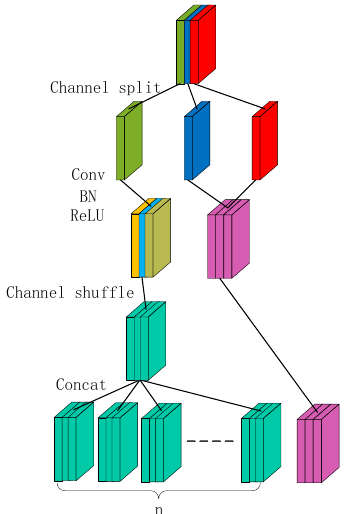
Figure 3. CS structure schematic.